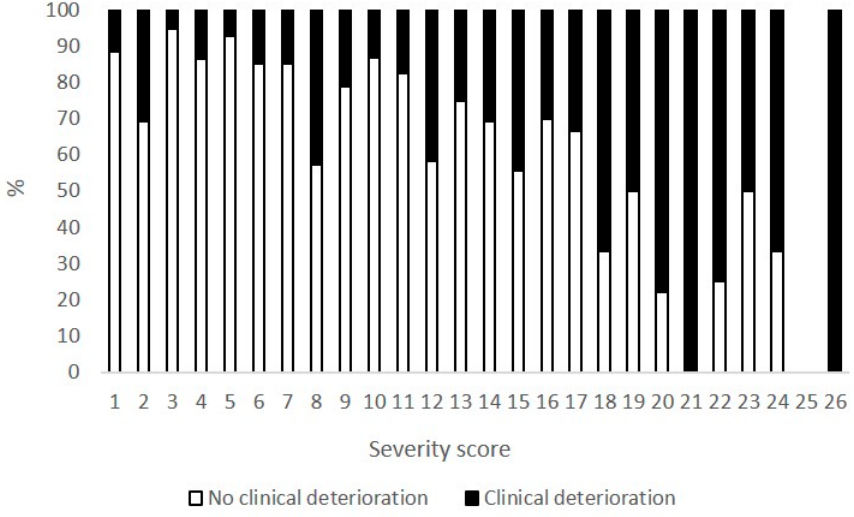
Figure A2. Outcome percentages stratified by different severity scores.